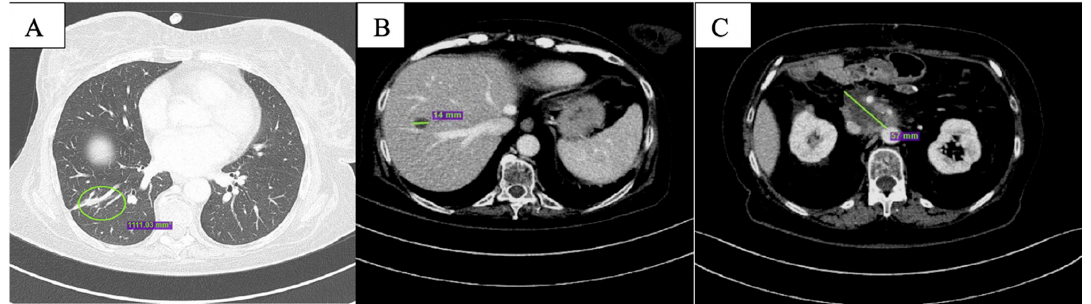
Figure 2. CT scan after the first 2 months of olaparib showing complete response of the nodular lesion in inferior lobe of the right lung ( A ), reduction in size of the hepatic lesion in the 8th segment ( B ) and of peripancreatic tissue ( C ).